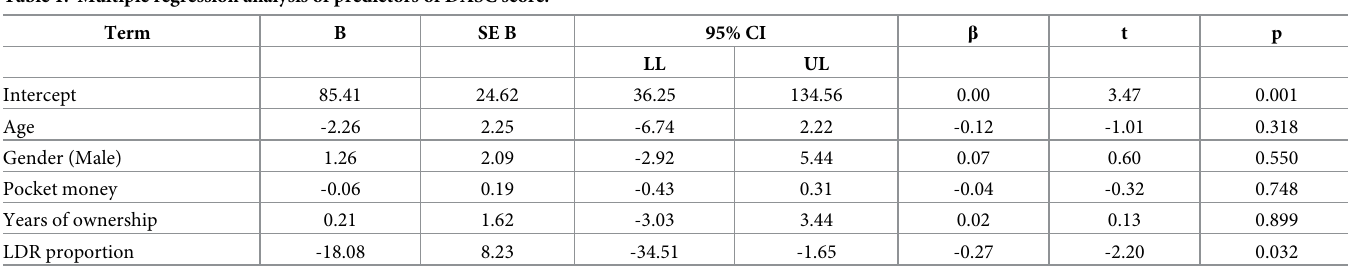
Table 1. Multiple regression analysis of predictors of DASC score.